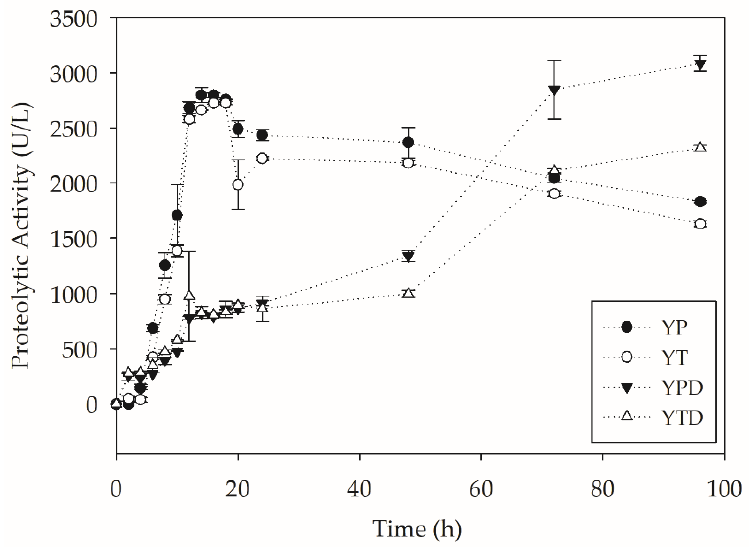
Figure 5. Protease activity during PC-PET biodepolymerization by submerged cultures of Y. lipolytica IMUFRJ 50682 at 28 °C and 250 rpm for 96 h.